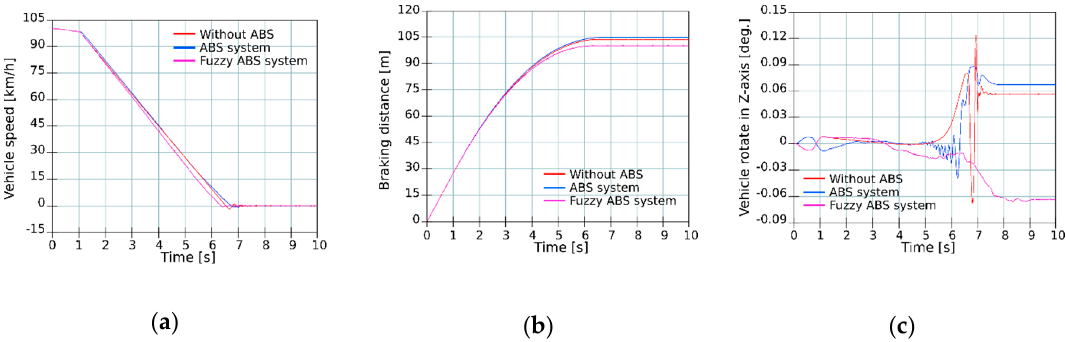
Figure 10. Test on dry road at speed 100 km/h—( a ) Speed curve; ( b ) Braking distance; ( c ) Vehicle rotation. Table 3. Test results on dry road at speed 100 km/h.